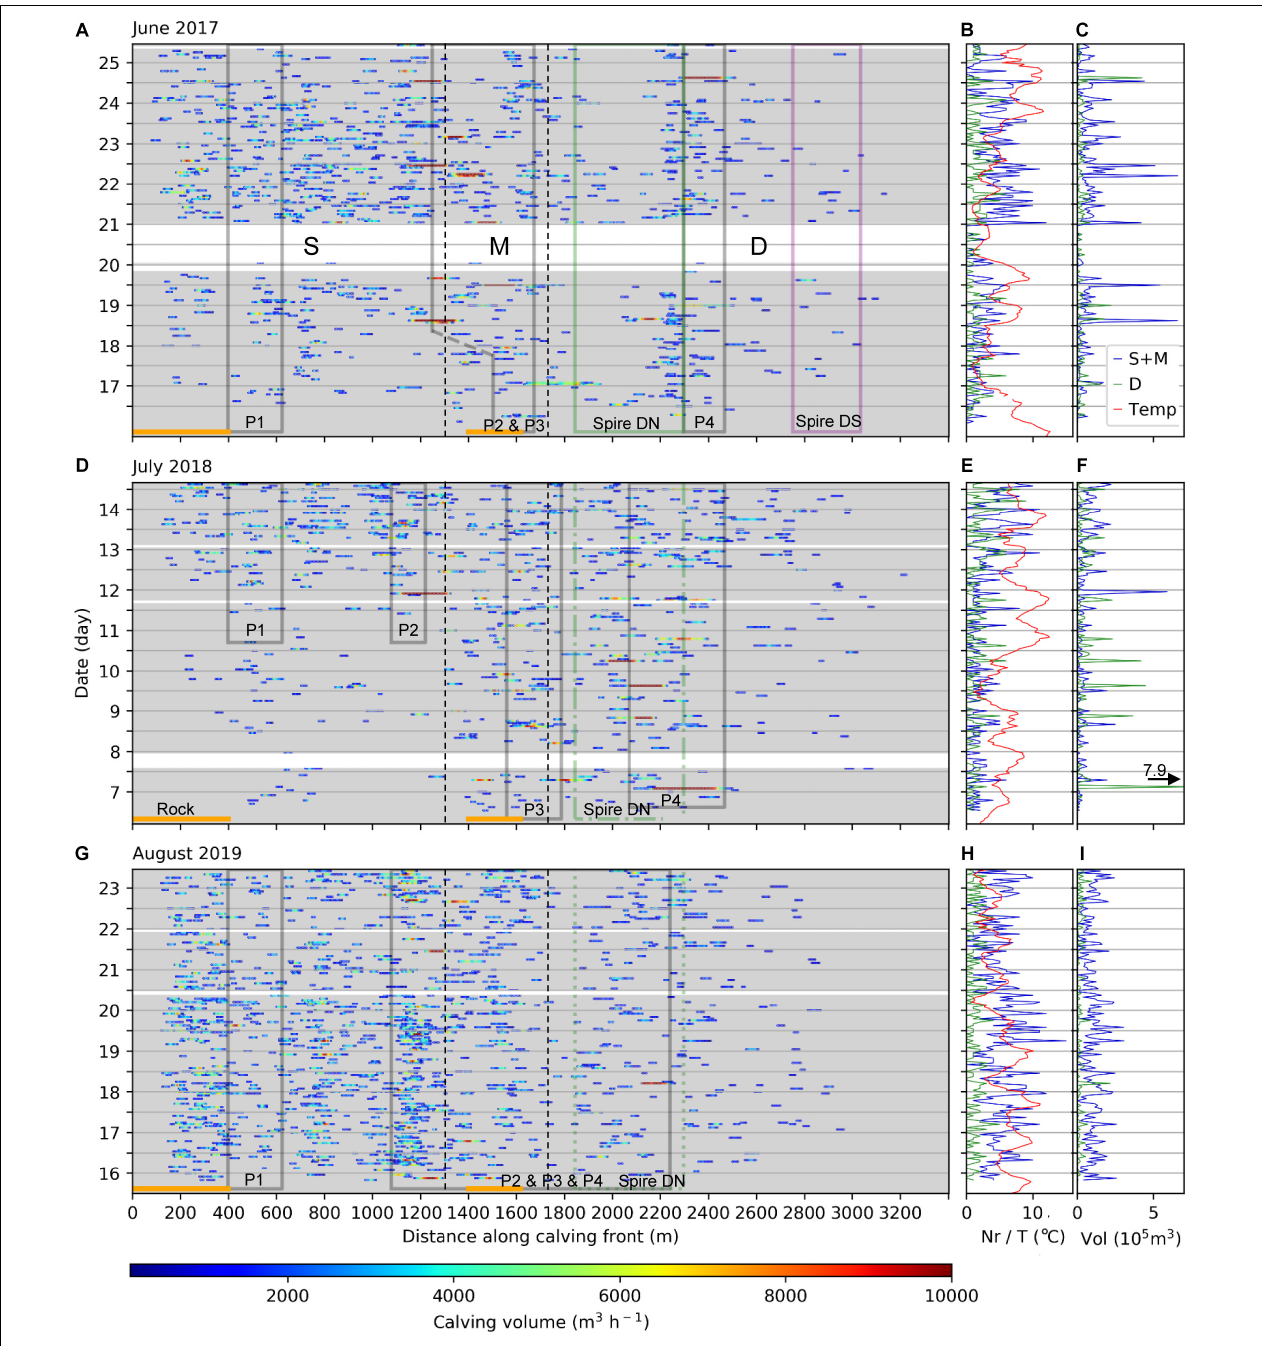
FIGURE 13 | Same as Figure 12 but for the field campaigns in (A) 2017, (D) 2018 and (G) 2019.